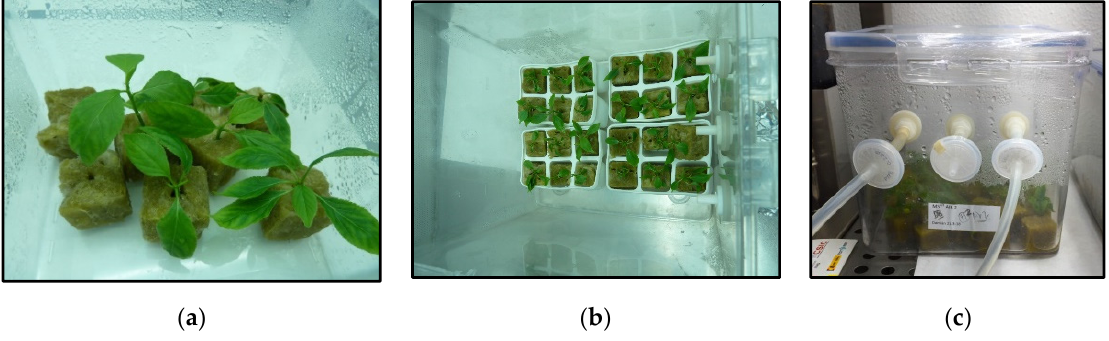
Figure 3. ( a , b ) Shoots of CBP inserted in rockwool cubes for rooting expression and ( c ) shoots in- serted in a Plantform™ bioreactor without the inner